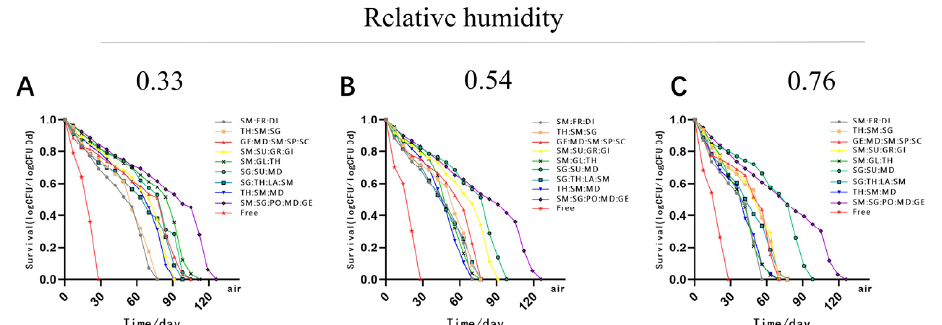
Figure 3. The number of viable cells in the microencapsulated LR-LFCA stored at 25 °C, with relative humidity values of approximately 0.33 ( A ), 0.54 ( B ), or 0.76 ( C ).